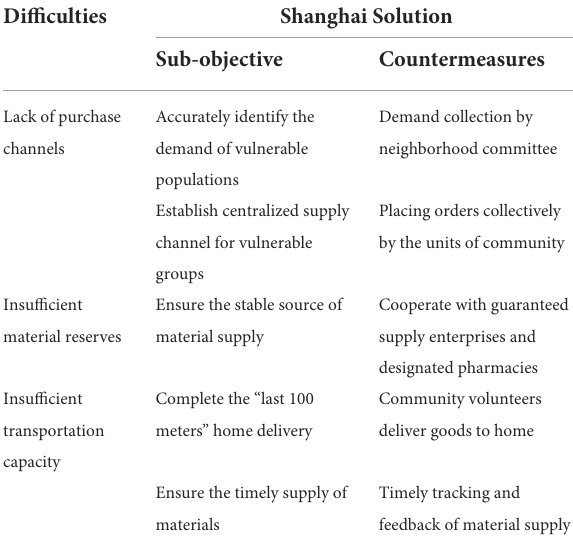
TABLE 1 The difficulties and countermeasures of the Shanghai